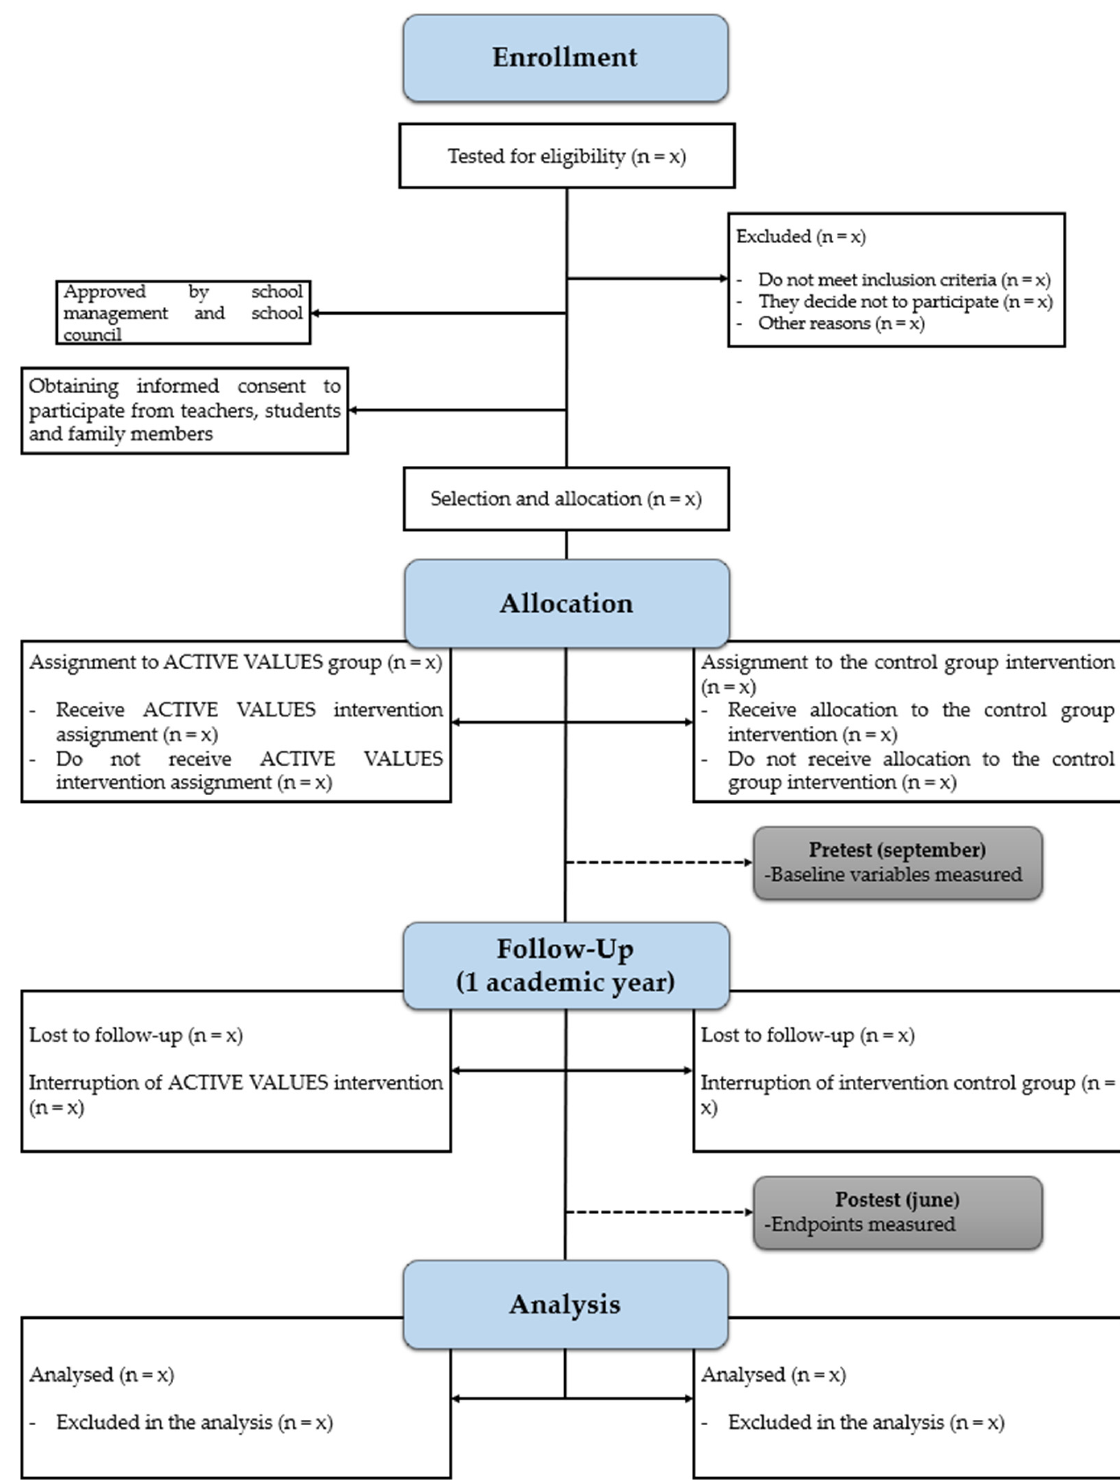
Figure 3. Participant flow diagram. Adapted from Sánchez-López et al. [7] and Toivonen et al. [26].